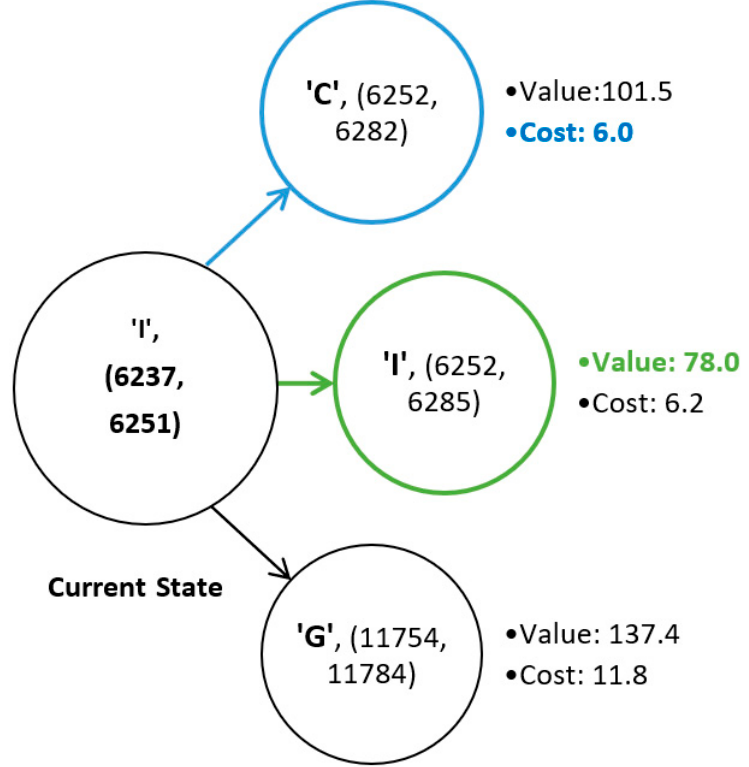
Figure 9. Sample Value and Cost of Next States.